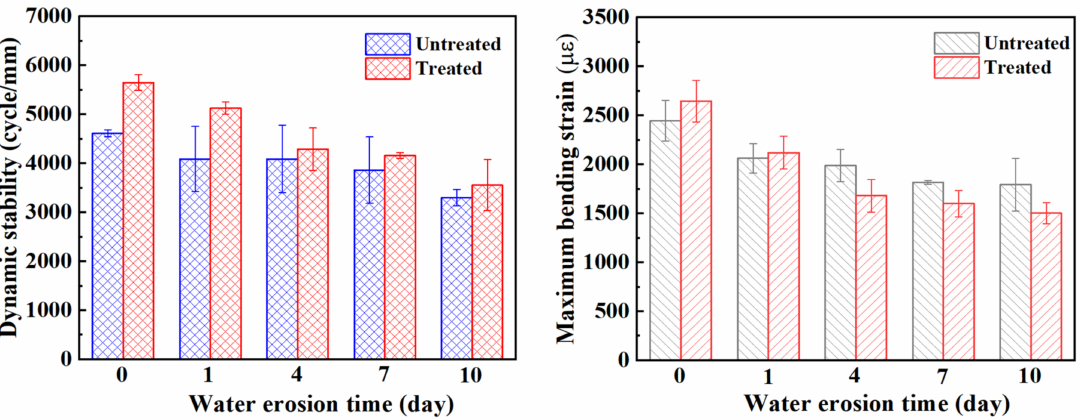
Figure 11. Dynamic stability and maximum bending strain of steel slag asphalt mixture under different water erosion